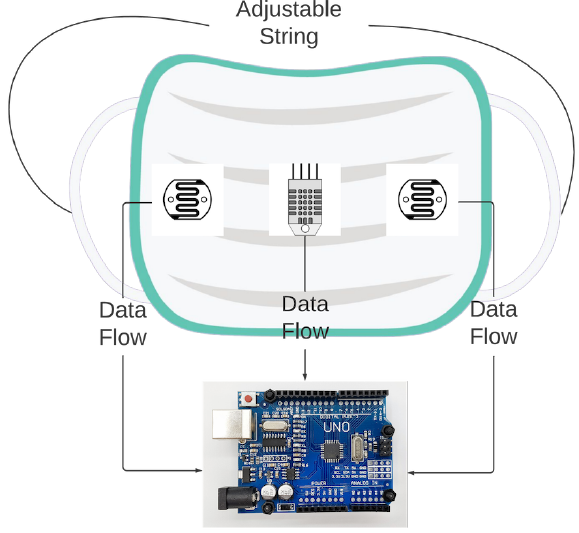
Figure 2. Prototype of the smart mask for Stage 1